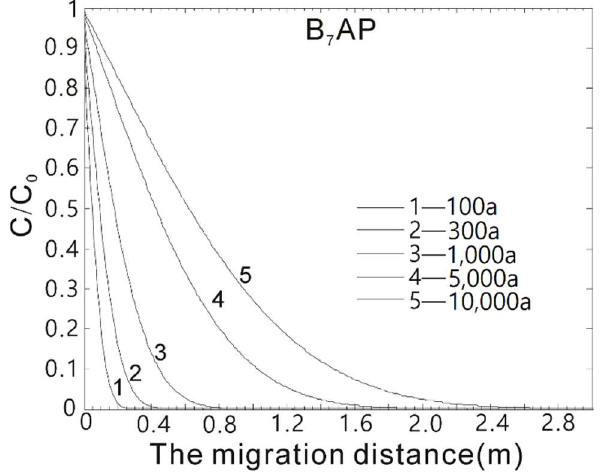
Figure 4. Migration distance of uranium in B 7 AP at different time scales.